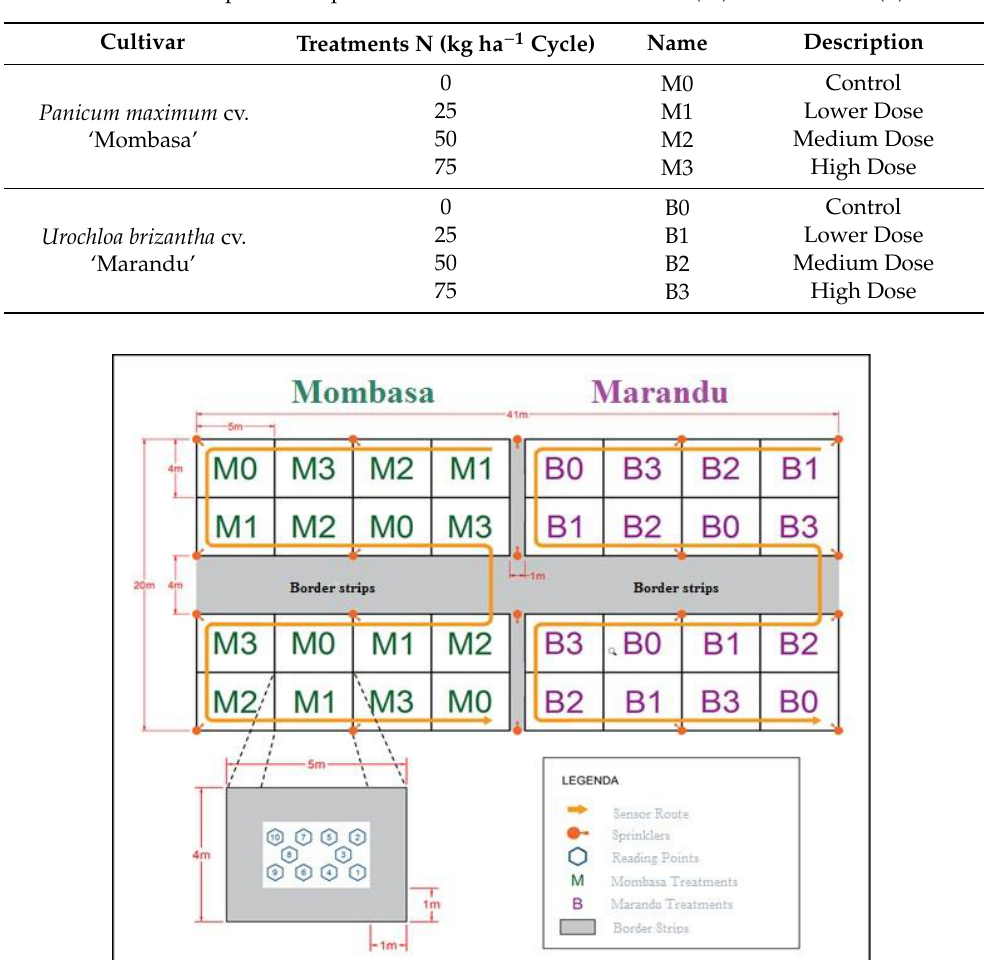
Figure 1. Experimental area with N treatments for the cultivars Mombasa (M) and Marandu